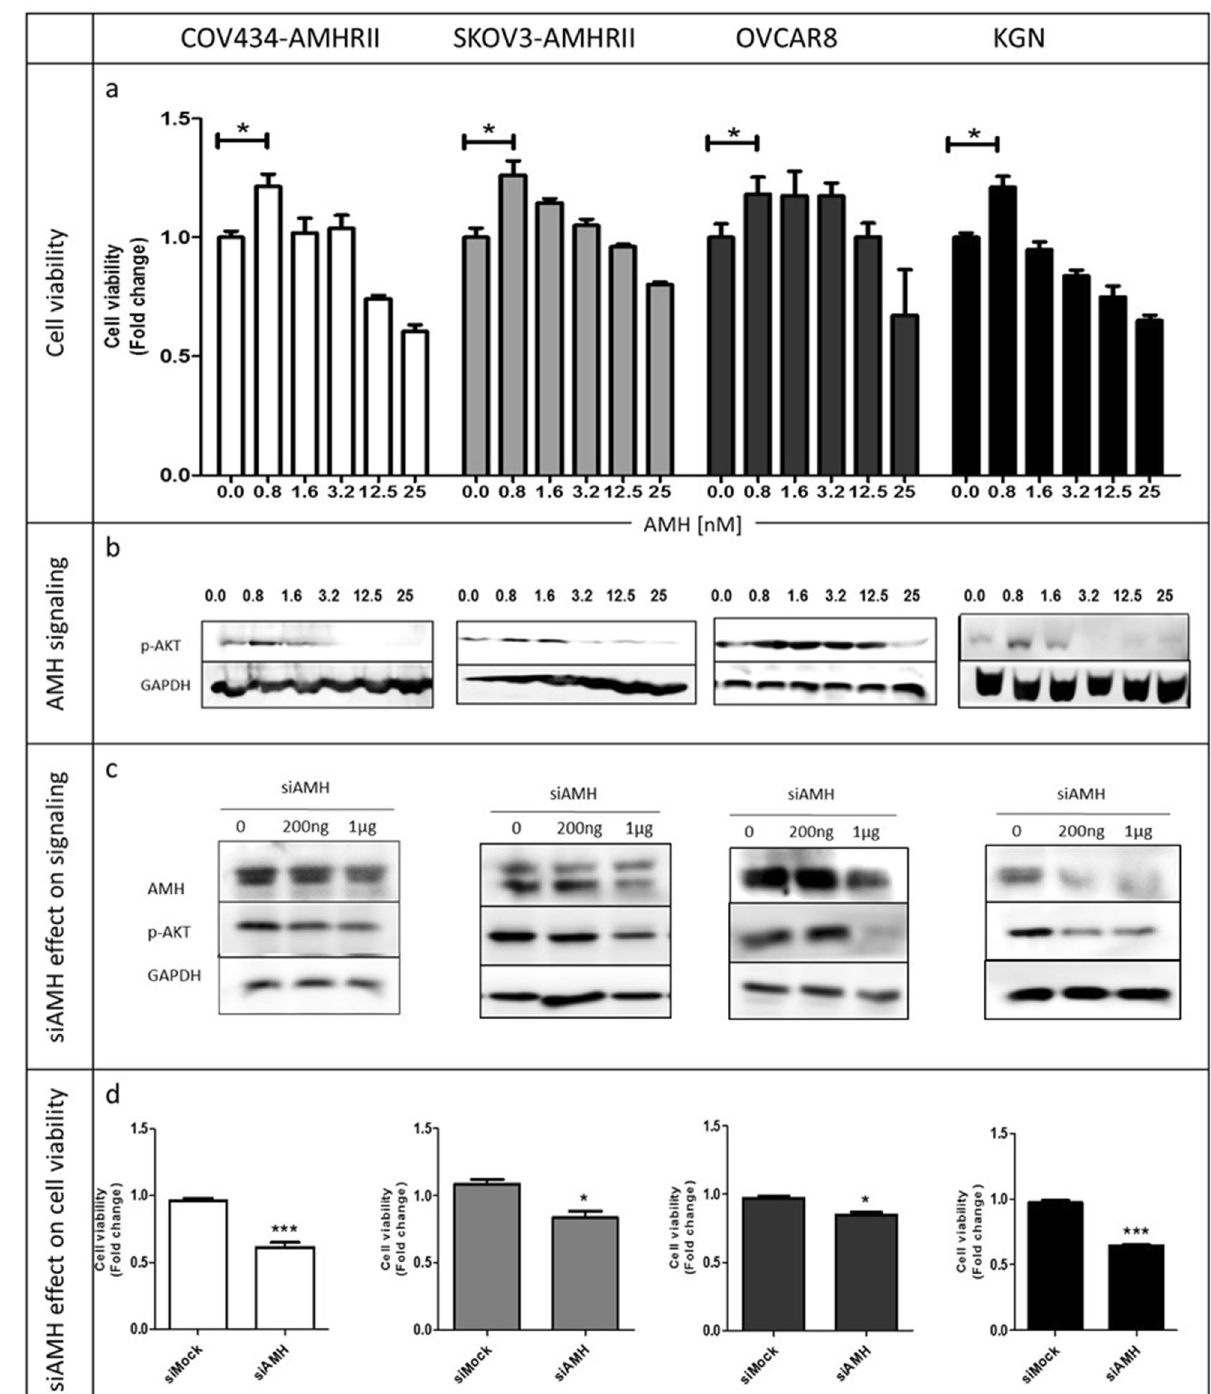
Figure 1. Low-dose recombinant AMH (LR-AMH) promotes cell viability in COV434-AMHRII, SKOV3- AMHRII, OVCAR8 and KGN cells. ( a ) Cell viability (MTS assay) and ( b ) AKT phosphorylation (western blotting) after incubation with 0.8 to 25 nM LR-AMH for 3 days. ( c ) AMH expression at 48 h after transfection of siRNAs against AMH, and ( d ) Effect of siRNA-mediated AMH silencing on cell viability at day 3 post- transfection. Figure shows a representative experiment out of 2 to 4 experiments performed depending on the cell line (mean ± SEM of 3 replicate wells) *p < 0.05; ***p < 0.001. For western blot figure preparation, all proteins were analyzed on the same gel and membrane. After blotting, the lines corresponding to the different proteins were cut and may have been exposed for different lengths of time because the objective was not to compare the different proteins with each other, but to see the effect of AMH ( b ) or of siRNA ( c ) on the expression of each